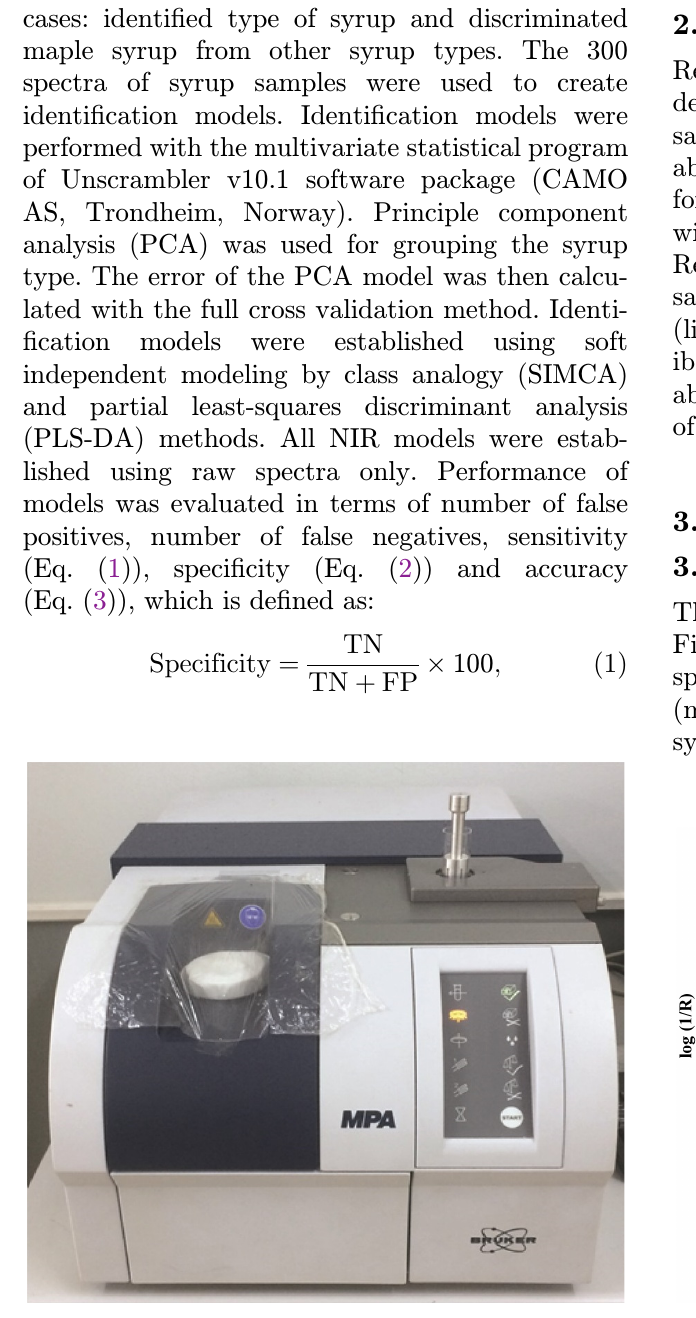
Fig. 1. Syrup spectra measurement by FT-NIR spectrometer. Fig. 2. Raw spectra of